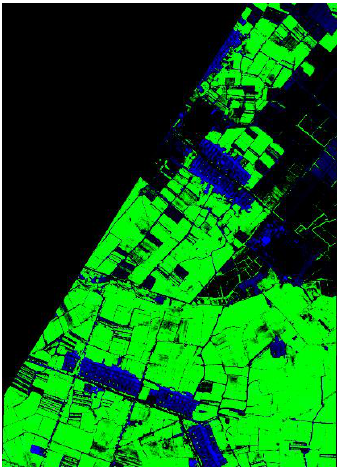
Figure 6. The composite image after the minimum noise fraction (MNF) transform.